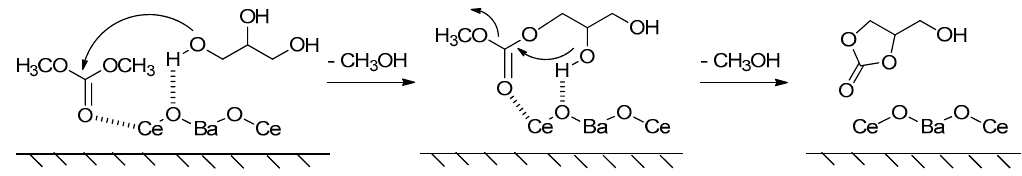
Figure 9. Heterogeneous catalysis in the transesterification of glycerol, (reprinted with permission from Reference [92], American Chemical Society, 2017).